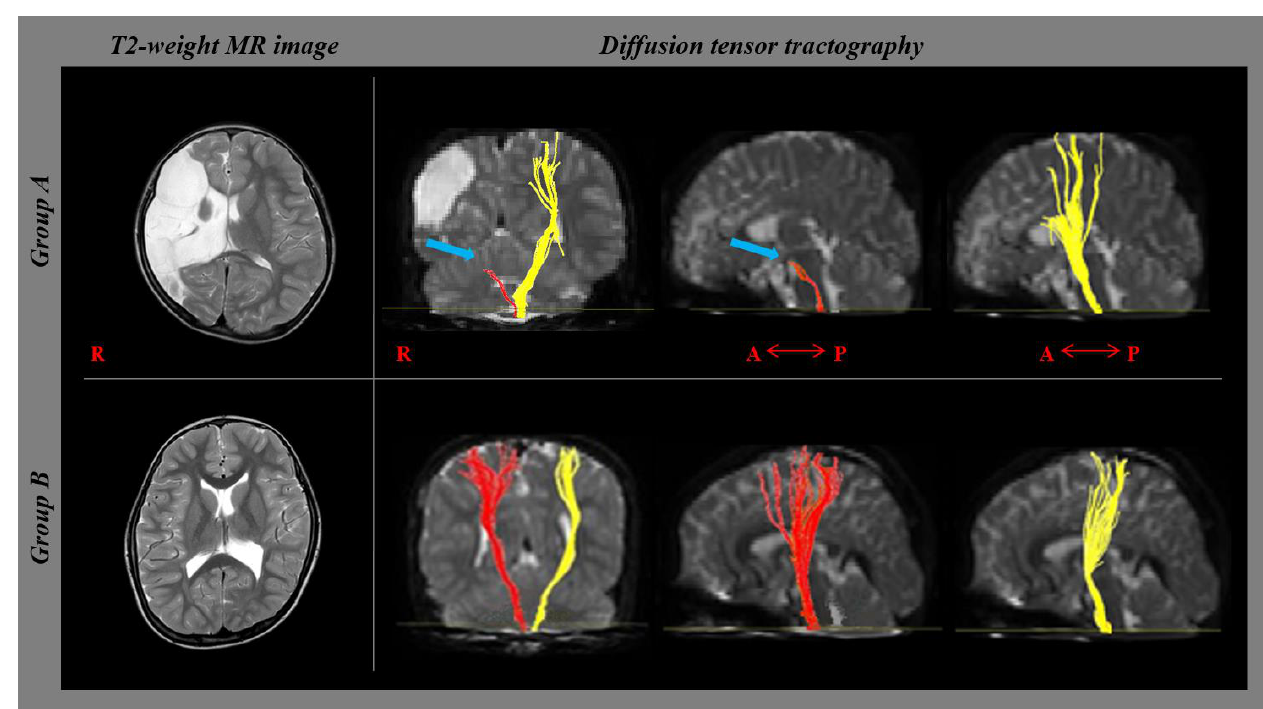
Figure 2. Diffusion tensor tractography of the corticospinal tract in patients. ( A ) shows the disruption of the right corticospinal tract (blue arrow) in patient who were diagnosed as left hemiplegic cerebral palsy. ( B ) shows preservation of both corticospinal tracts to the cortex level, although the left one has mildy decreased fiber volume compared to right one. Patient B was diagnosed with right hemiplegic cerebral palsy.